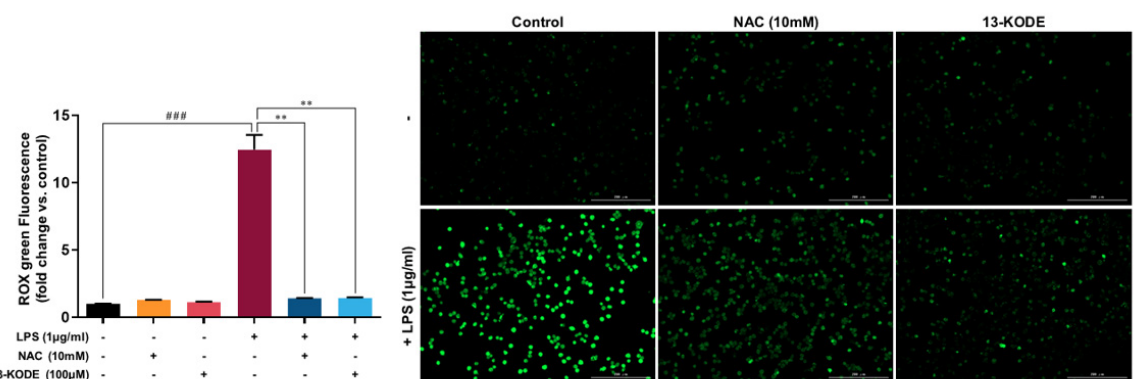
Figure 5. Inhibition of the LPS-induced activation of MAPKs by 13-KODE in RAW 264.7 macrophages. The cells were treated with 100 µ M of 13-KODE for 1 h prior to exposure to LPS (1 µ g/mL) for 30 min and total protein was isolated. The protein extracts were subject to SDS-PAGE followed by Western blot analysis using the indicated primary antibodies. The amount of β -actin served as the internal control. pERK1/2, p-p38, and pJNK levels were determined. The values represent the mean ± standard deviation, n = 3. ** p < 0.01; *** p < 0.001.